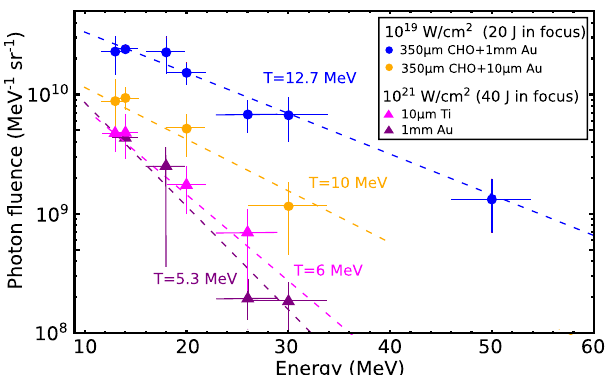
Fig. 3 MeV-bremsstrahlung. MeV-bremsstrahlung fl uence in dependence on energies from different laser-target setups described in the legend, where used combined aerogel (CHO) with two different thick gold (Au) targets (data as blue and yellow dots) as well as thin and thick metal targets, only (data as magenta and purple triangles). The error bars represent the accuracy of reaction yield and the width of nuclear resonance used for spectral reconstruction (see Methods). Dashed lines are thermal exponential fi ts on the experimental